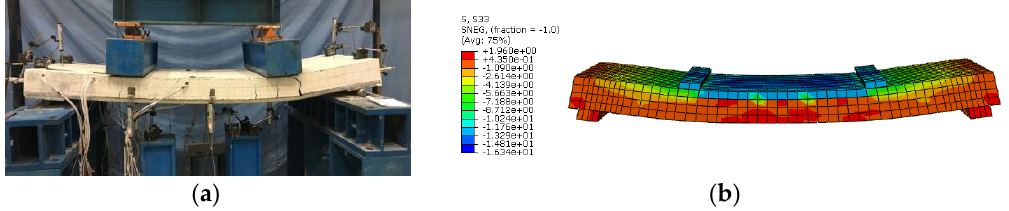
Figure 18. Comparison of failure modes for specimens (for SCRLC30-B-1 slabs): ( a ) test failure; ( b ) FEA failure.